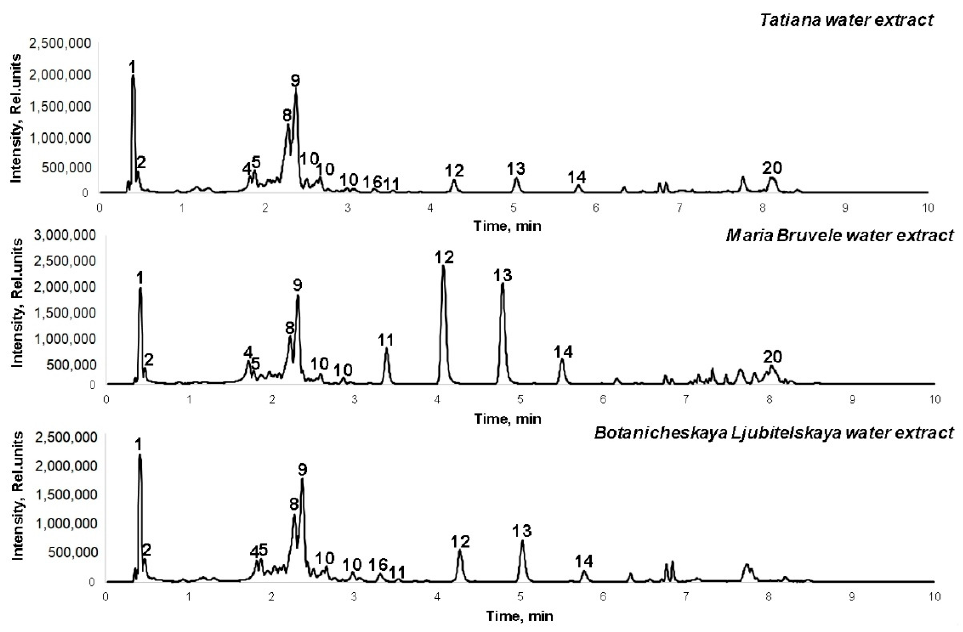
Figure 4. UHPLC-TOF/MS chromatograms of the water extracts of SBT samples.